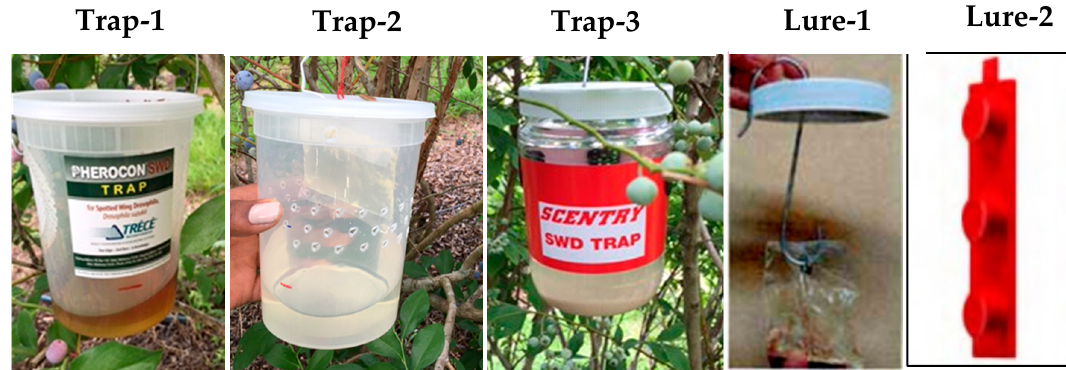
Figure 2. Photos of traps (color and shapes) and lures used in the study: Trap-1 (Trécé trap), Trap-2 (Cup trap), Trap-3 (Scentry trap), Lure-1 (Scentry trap lure), and Lure-2 (Trécé trap lure).